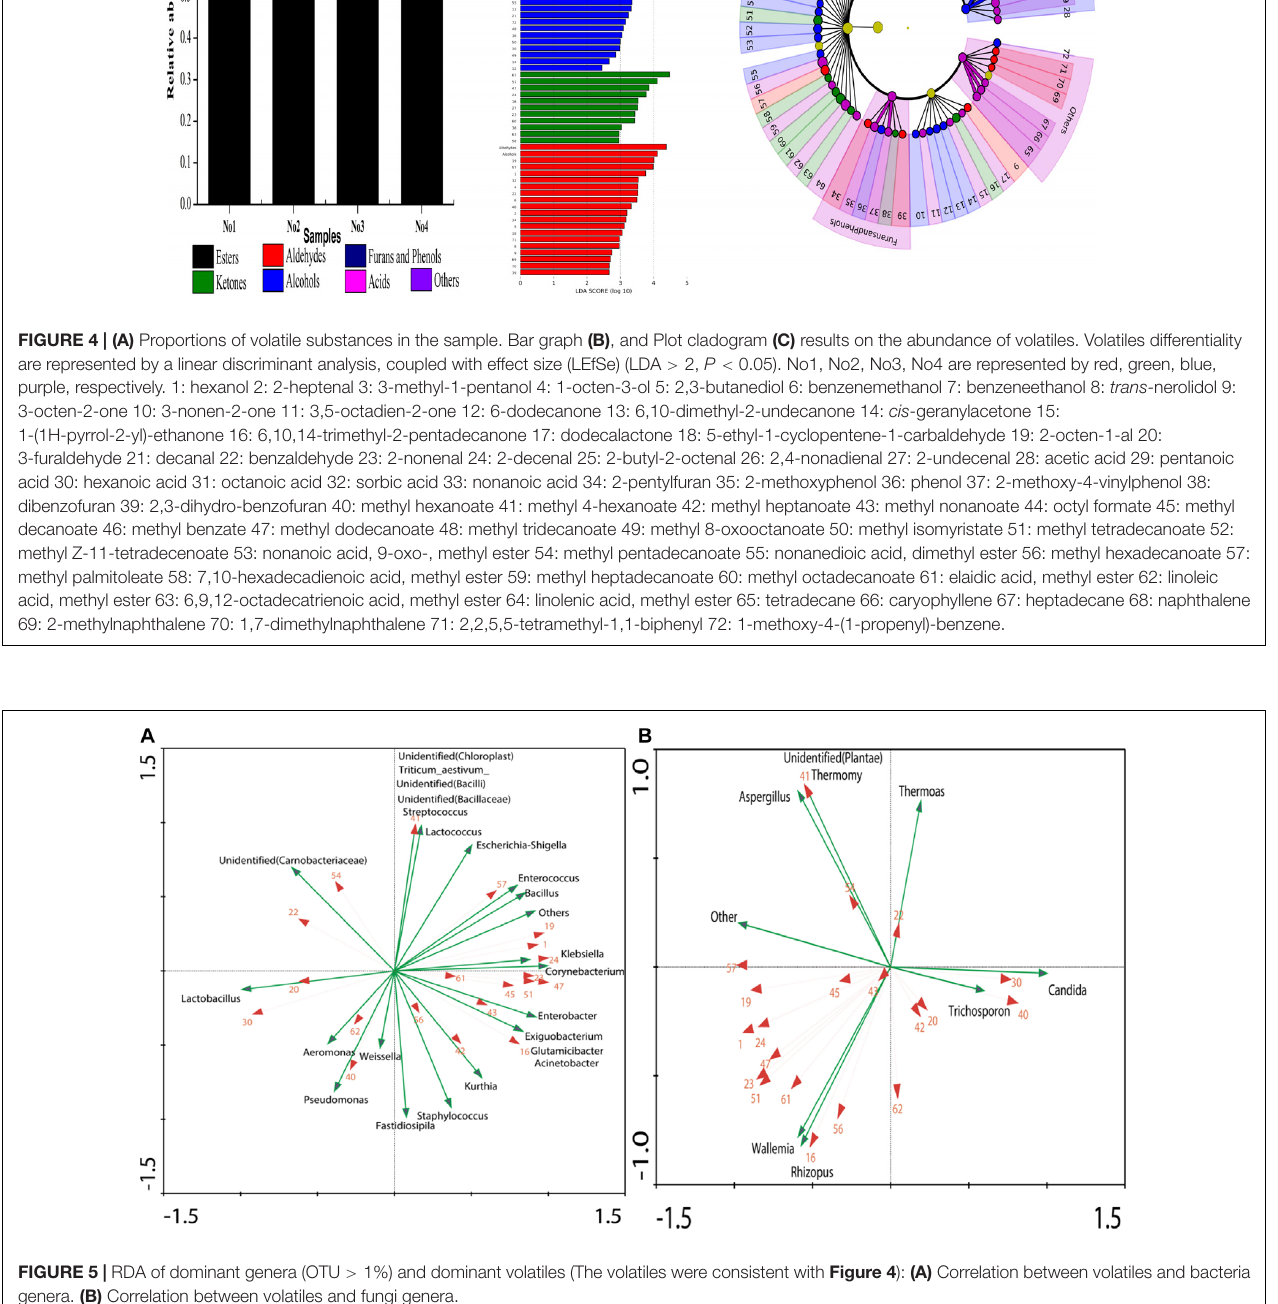
Frontiers in Microbiology |